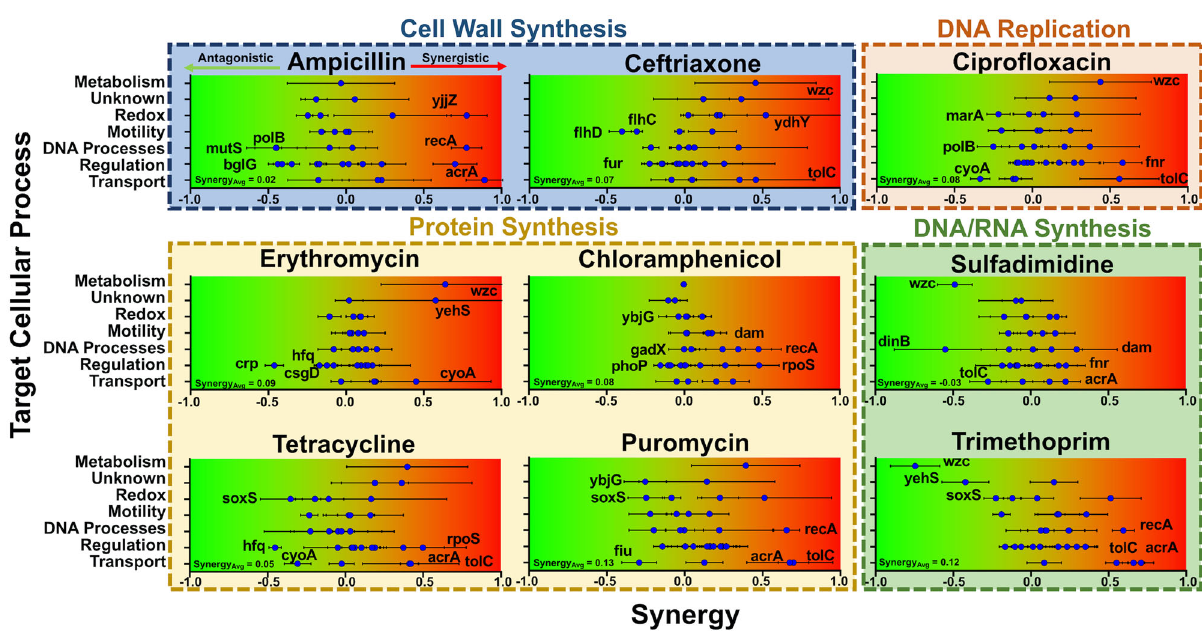
Fig. 2 Correlations in gene – drug synergy. Degree of synergy between gene knockouts and antibiotic treatments, grouped by biological mechanisms. Gene knockouts are separated into their speci fi c cellular processes on the y -axis, with corresponding synergy plotted on the x -axis, going from antagonistic (green, left) to synergistic (red, right). Antibiotics are further grouped based on the mechanism of action, such as targeting cell wall synthesis. The top three synergistic interactions and top three antagonistic interactions are speci fi cally labeled in each graph. In the bottom left of each graph is listed the average synergy of all thirty gene knockouts with the speci fi c antibiotic. Error bars represent standard deviation of at least three biological replicates propagated from fi tness